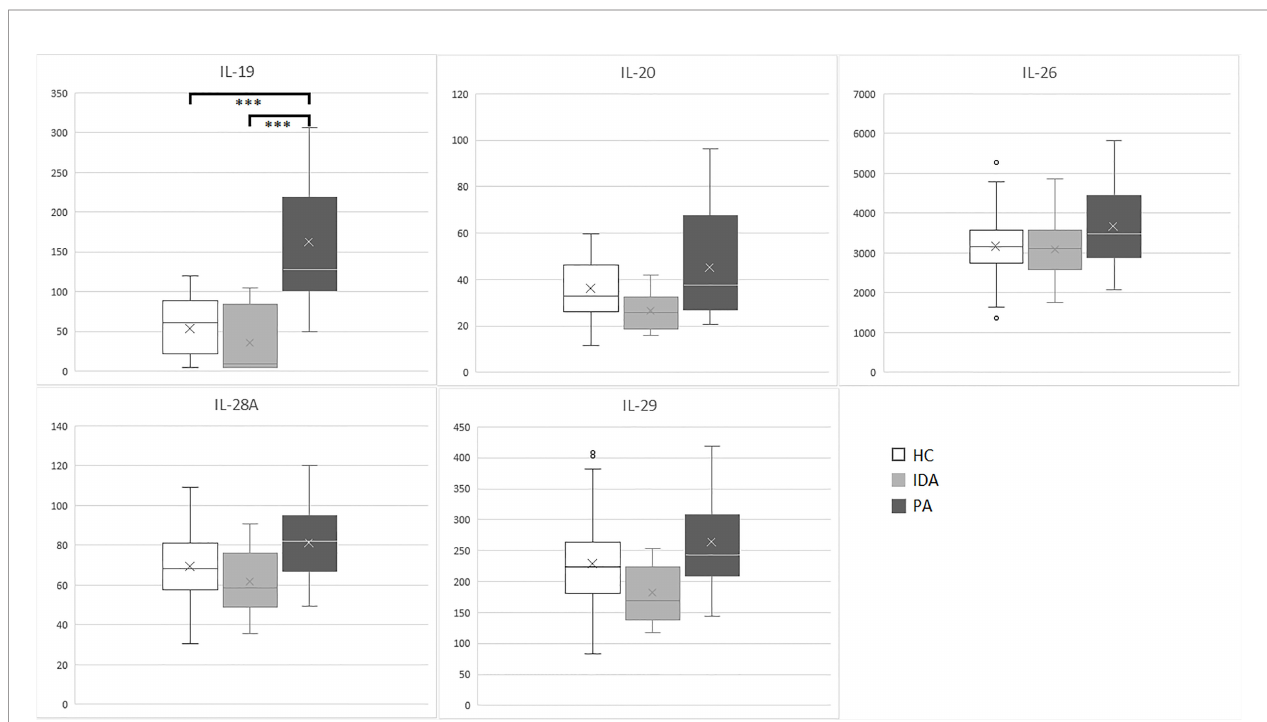
FIGURE 1 | IL-19, IL-20, IL-26, IL-28A and IL-29 (pg/ml) levels in sera samples of enrolled subjects (PA, pernicious anemia; IDA, iron de fi cient anemia; HC, healthy control). *** p <